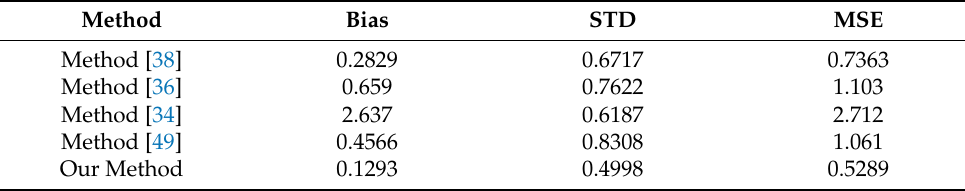
Table 2. Results of the compared methods for all